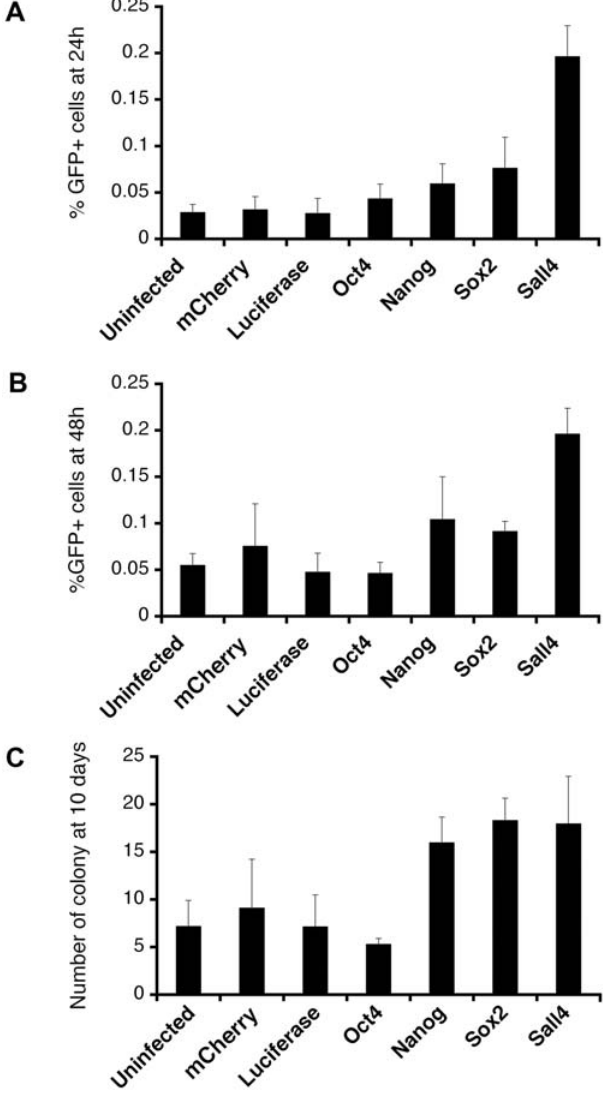
Figure 3. Overexpression of Sall4 enhanced Oct4-gfp expres- sion and ES cell-like colony formation in MEFs during reprogramming. The percentage of GFP positive MEFs at: A) 24 h and B) 48 h post-fusion. C) The number of GFP positive, G418-resistant colonies in 1 well of a 6-well plate, 10 days post-fusion. The overexpression of Sall4 positively enhanced both Oct4-gfp expression and colony formation of MEFs upon reprogramming.